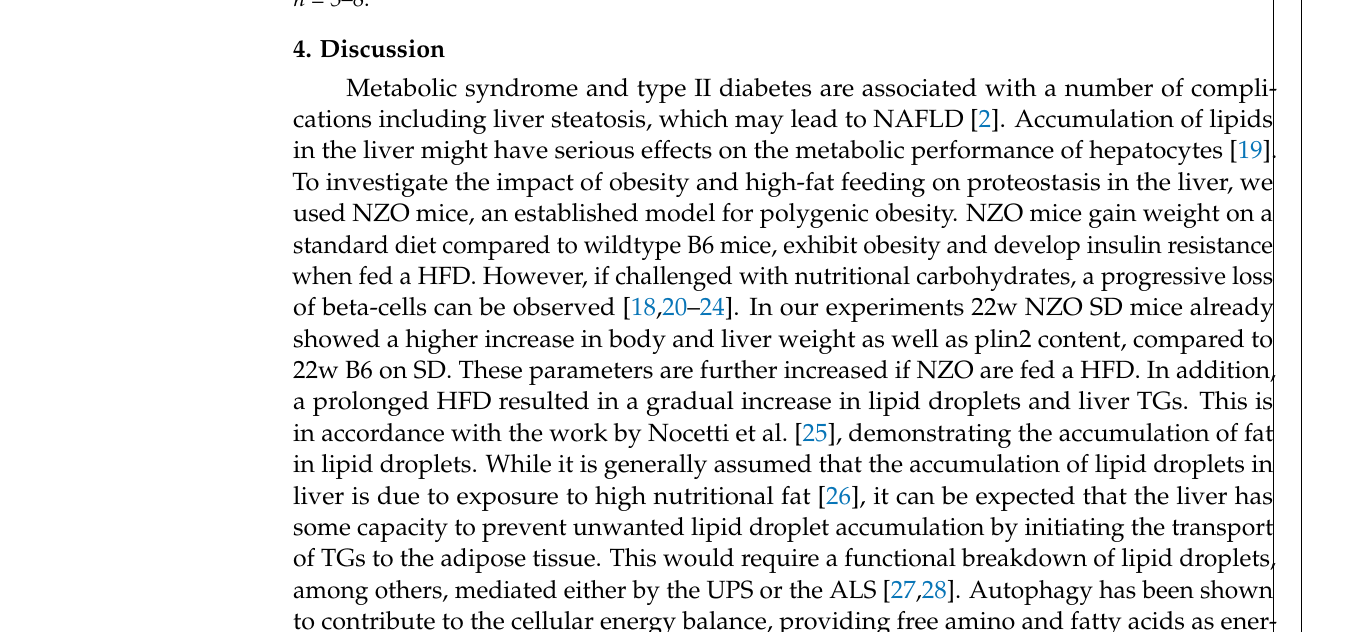
Figure 4. Nonenzymatic protein modification in liver of high-fat diet exposed mice. Protein-bound 3-nitrotyrosine (panel A ) and 4-hydroxynonenal-protein modification (panel B ) were determined by immunoblotting as described in the methods section. Each panel shows a representative blot and the corresponding ponceau staining. All data were normalized towards 22w SD B6 (set as ‘1′). Statistical analysis was performed by one sample t-test (indicated by #) or unpaired t-test (indicated by *), directly comparing two selected samples. Statistical significance means: a—versus 22w B6; b—vs. 39w B6; c—vs. 22w NZO SD; and d—vs 22w NZO HFD. The data presented are the mean ± standard deviation, n = 5–8.